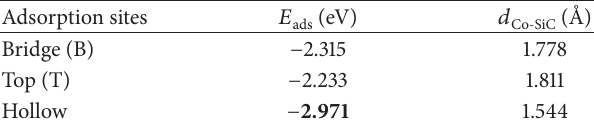
Table 1: The adsorption energies at different adsorptive sites for the Co adatom on graphite.